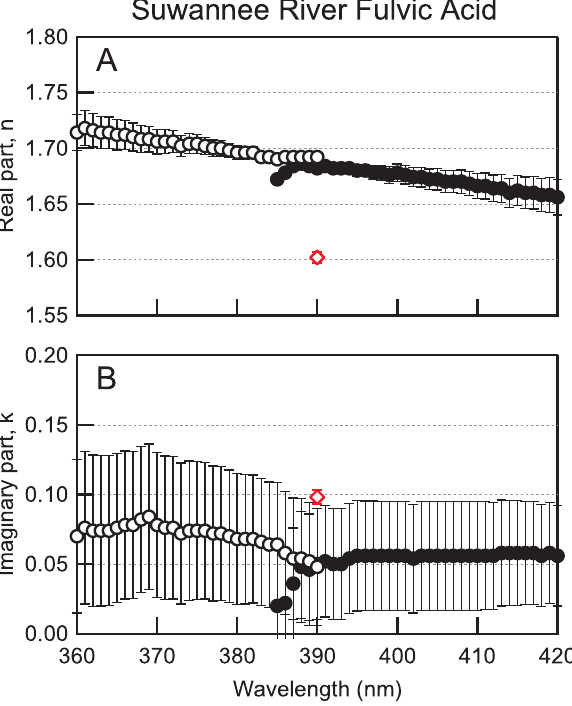
Fig. 10. (a) The real part of the complex refractive index (RI) as a function of wavelength for SRFA aerosol. Red marker shows values reported by Dinar et al. (2008, diamond). (b) Similarly, the imagi- nary part of the